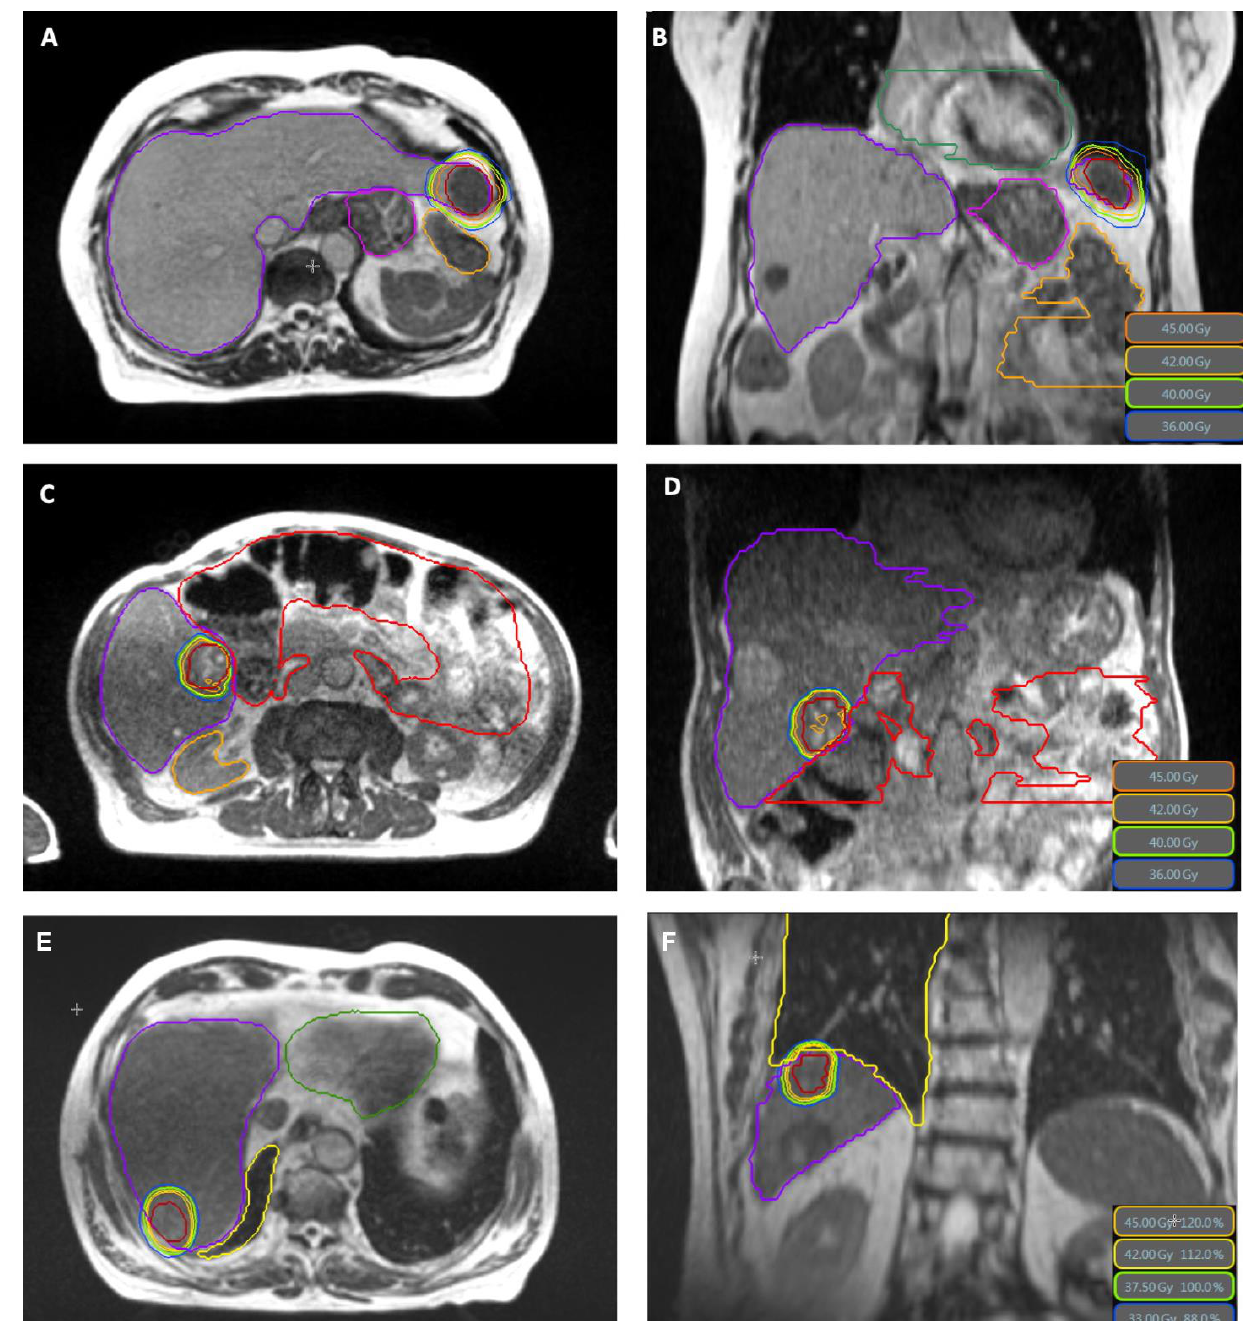
Figure 1. MR-based plans in axial and coronar plane (GTV in red color) with sparing of small bowel (orange), stomach (pink) and heart (green) in ( A ) and ( B ) and small bowel (red) in ( C ) and ( D ). ( E ) and ( F ) show the plan of the patient who suffered a duodenal perforation, with a clear distance between the treated volume and the duodenum. The PTV dose in this case was 37.5 Gy in 3 fractions prescribed to 65% isodose, GTV Mean BED 10 was 146.7 Gy.